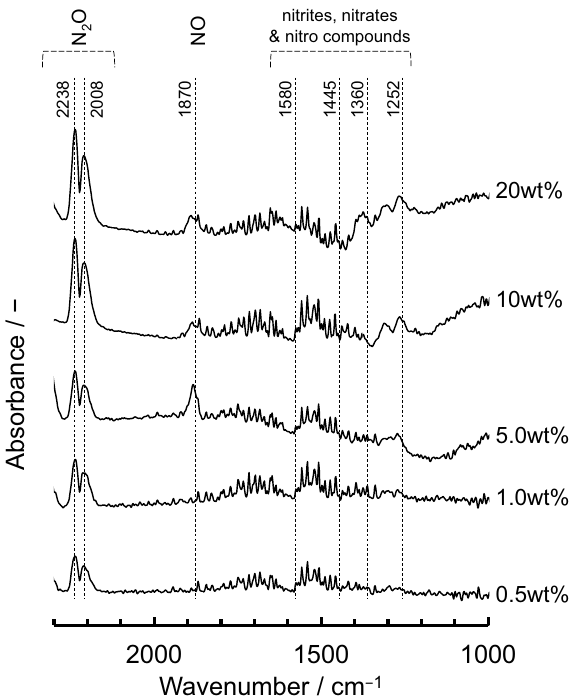
Figure 6. In situ FTIR spectra of N 2 O adsorbed on 0.5–20 wt% Ru/SnO 2 . The spectra were measured at 200 °C in gas feeds of 200 ppm of N 2 O and N 2